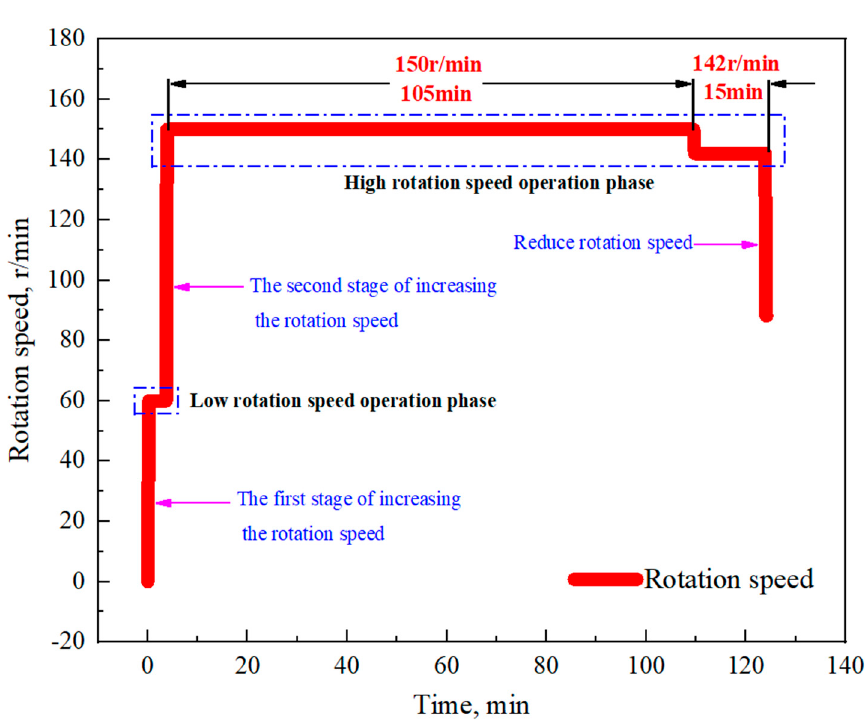
Figure 16. Rotation speed vs. time.